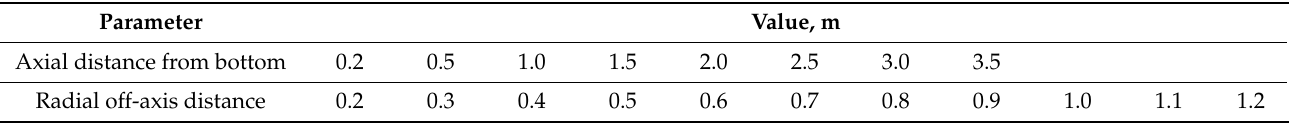
Table 4. Position of monitoring section and monitoring line (m).